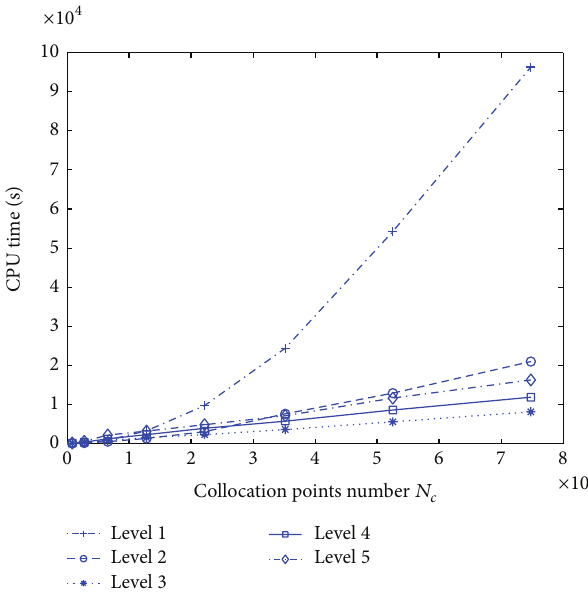
Figure 10: Zoom 1 of Figure